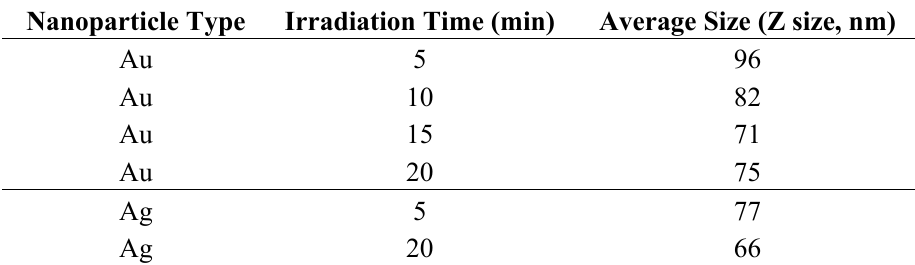
Table 1. Average size of Au and Ag NPs synthesized by laser